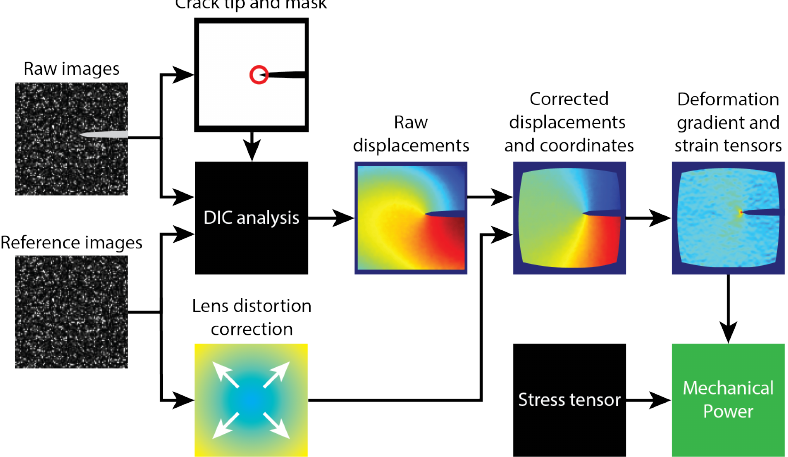
( a ) Chart of data processing for rapid photography images from a fatigue crack growth test. Figure 6.